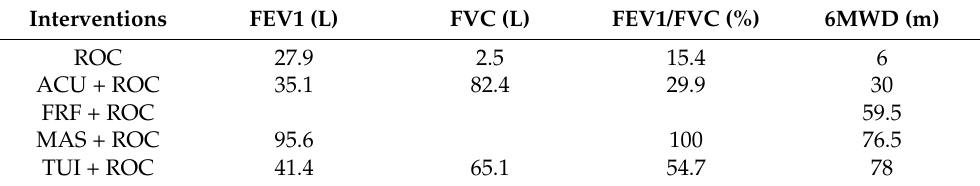
Table 5. SUCRA for interventions on each